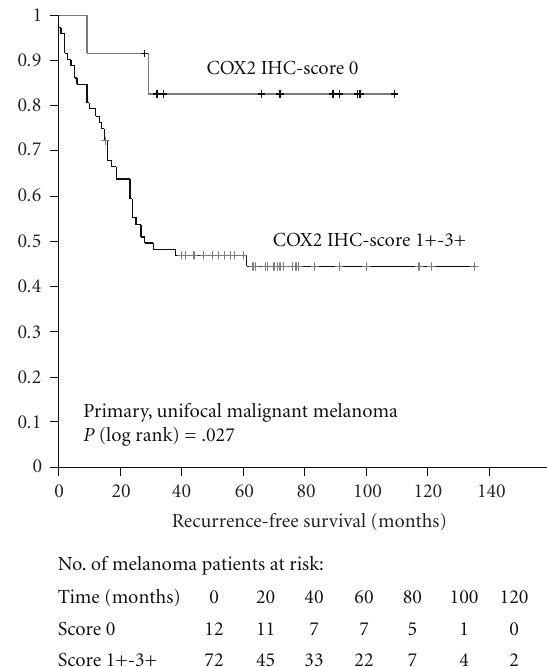
Figure 3: Distribution of time (months) to tumor-related death among patients with primary malignant melanomas showing negative (0) or positive (1+ to 3+) COX2 immunoreactivity as estimated by the Kaplan Meier